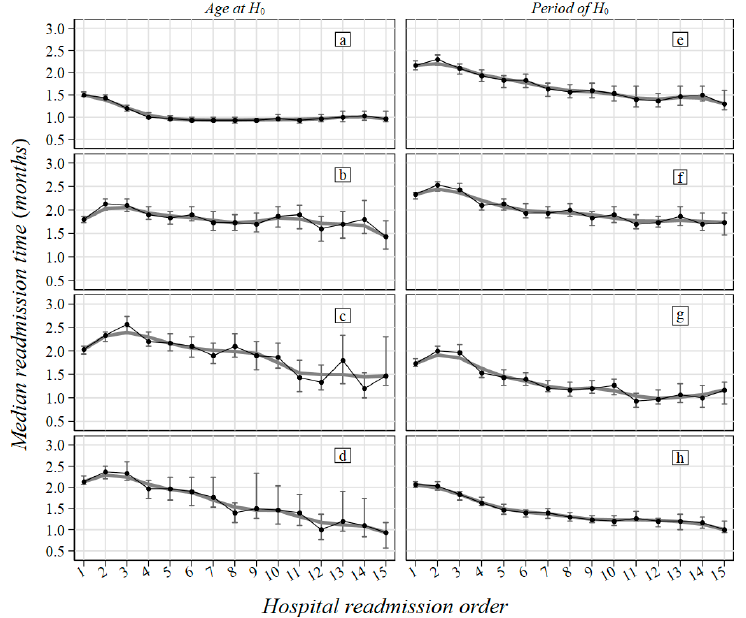
Figure 1. Median timespan between two consecutive hospitalizations for rare tumors by age at H 0 and period of H 0 in Liguria Region, 2000–2019. Legend—H 0 : index hospitalization (first admission); 95% CI: 95% confidence interval for median timespan; ( a ) 0–56 age group at H 0 ; ( b ) 57–69 age group at H 0 ; ( c ) 70–78 age group at H 0 ; ( d ) 79–103 age group at H 0 ; ( e ) 2000–2004; ( f ) 2005–2009; ( g ) 2010–2014; ( h ) 2015–2019.